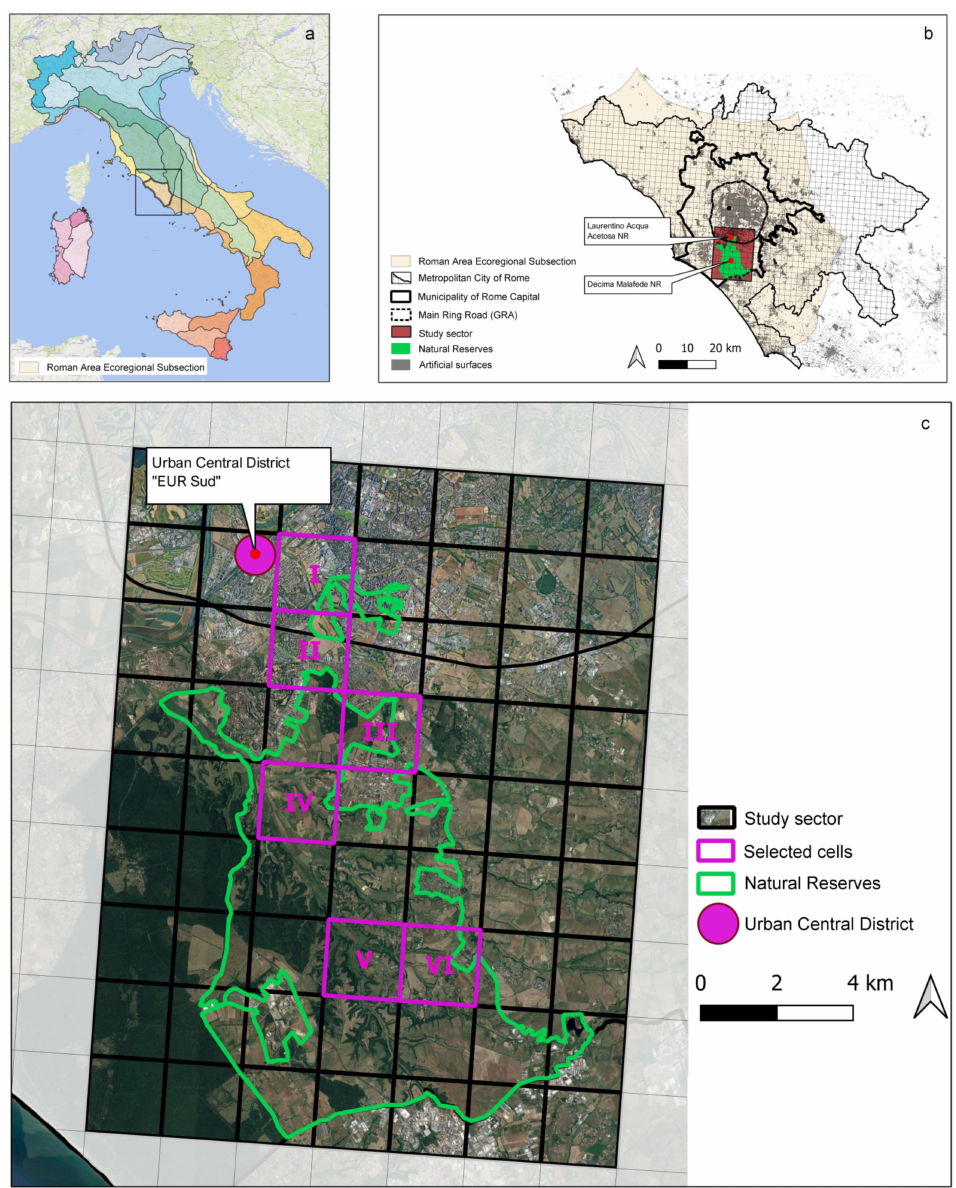
Figure 1. Study area: ( a ) broad scale ecoregional setting according to Blasi et al. [50]; ( b ) location of the study sector with respect to the “Roman area” ecoregional subsection and to the administrative boundaries of the municipality and Metropolitan City of Rome; ( c ) detail of the study area with the 6 selected cells, the boundaries of Decima-Malafede and Laurentino Acqua Acetosa Natural Reserves and the location of the nearest Urban Central District “EUR Sud”. Base map: Google Earth™